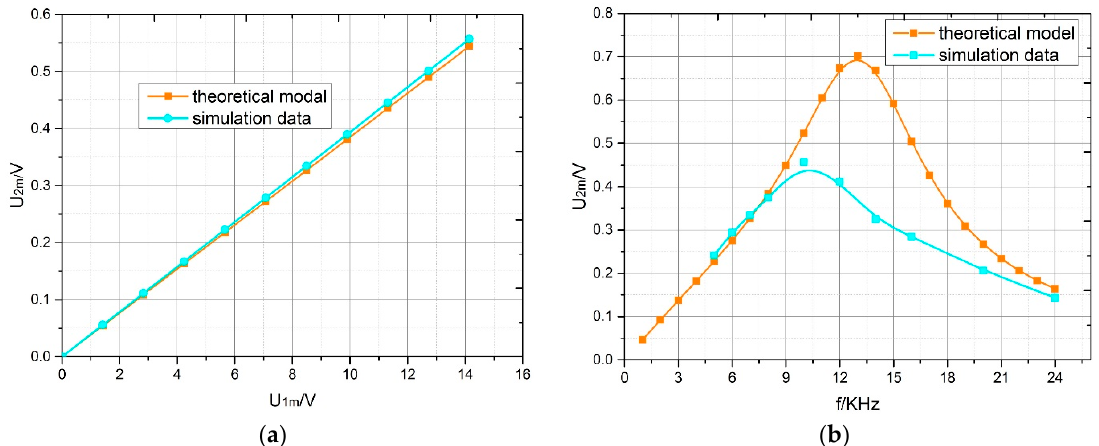
Figure 9. Variation of output voltage amplitude with excitation voltage frequency and amplitude in the theoretical model and simulation; α = 1°: ( a ) excitation voltage amplitude; ( b ) excitation voltage frequency.